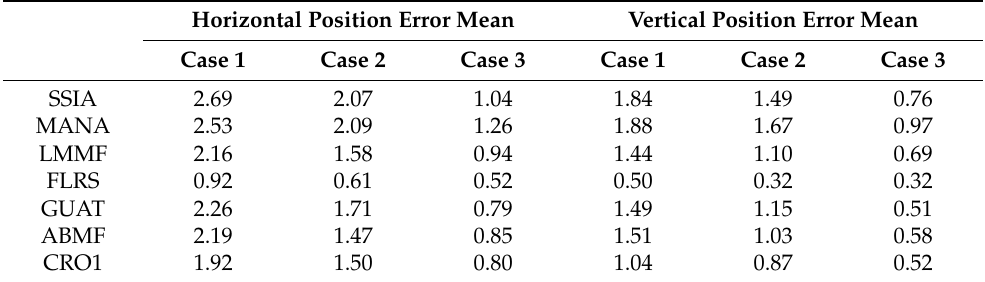
Table 5. One month mean of horizontal and vertical positioning errors in September 2013.